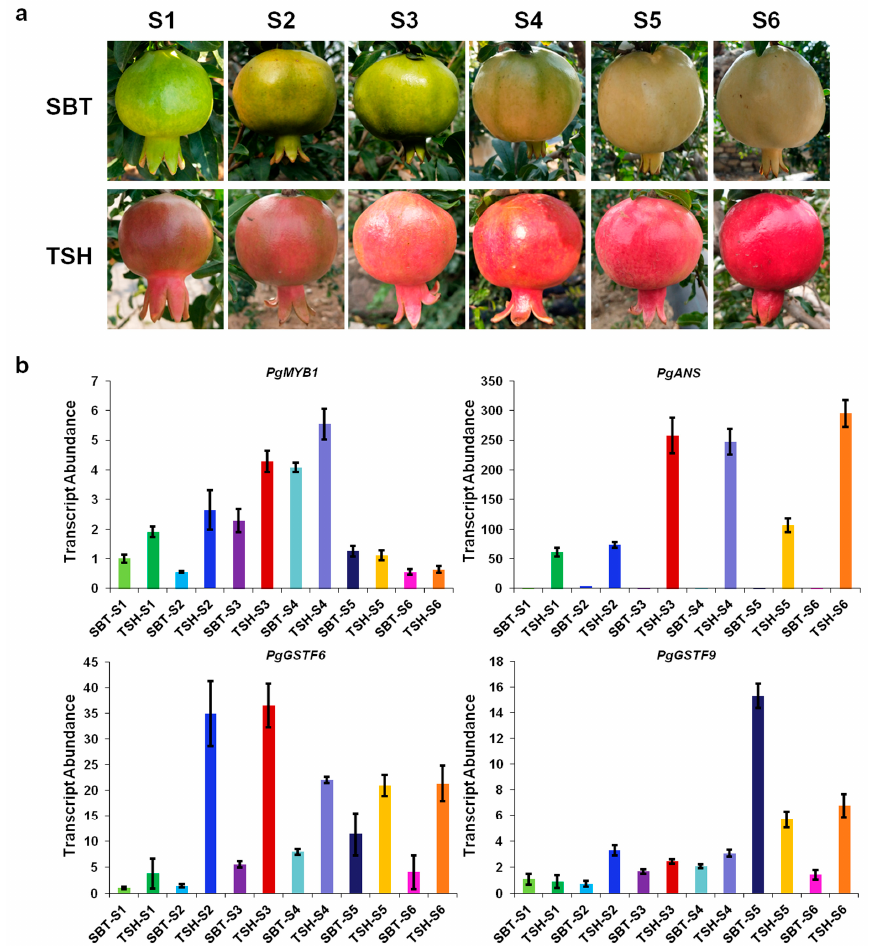
Figure 3. Expression patterns of PgMYB1 , PgANS , and PgGSTFs in different developmental stages of TSH and SBT. ( a ) Stages of development in TSH and SBT pomegranates. The stages are designated as S1, S2, S3, S4, S5, and S6. ( b ) The expression levels of PgMYB1 , PgANS , PgGSTF6 , and PgGSTF9 in the different stages of development in TSH and SBT fruits. qRT-PCR was conducted in three biological replicates and three technical replicates, and one representative biological repeat is shown.